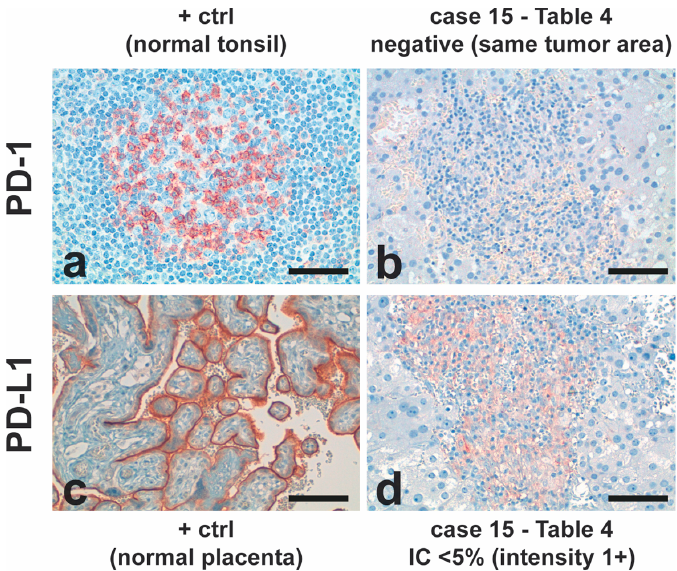
Figure 5. Programmed death 1 ( PD-1)/Programmed death-ligand 1 (PD-L1) staining profile in ACC